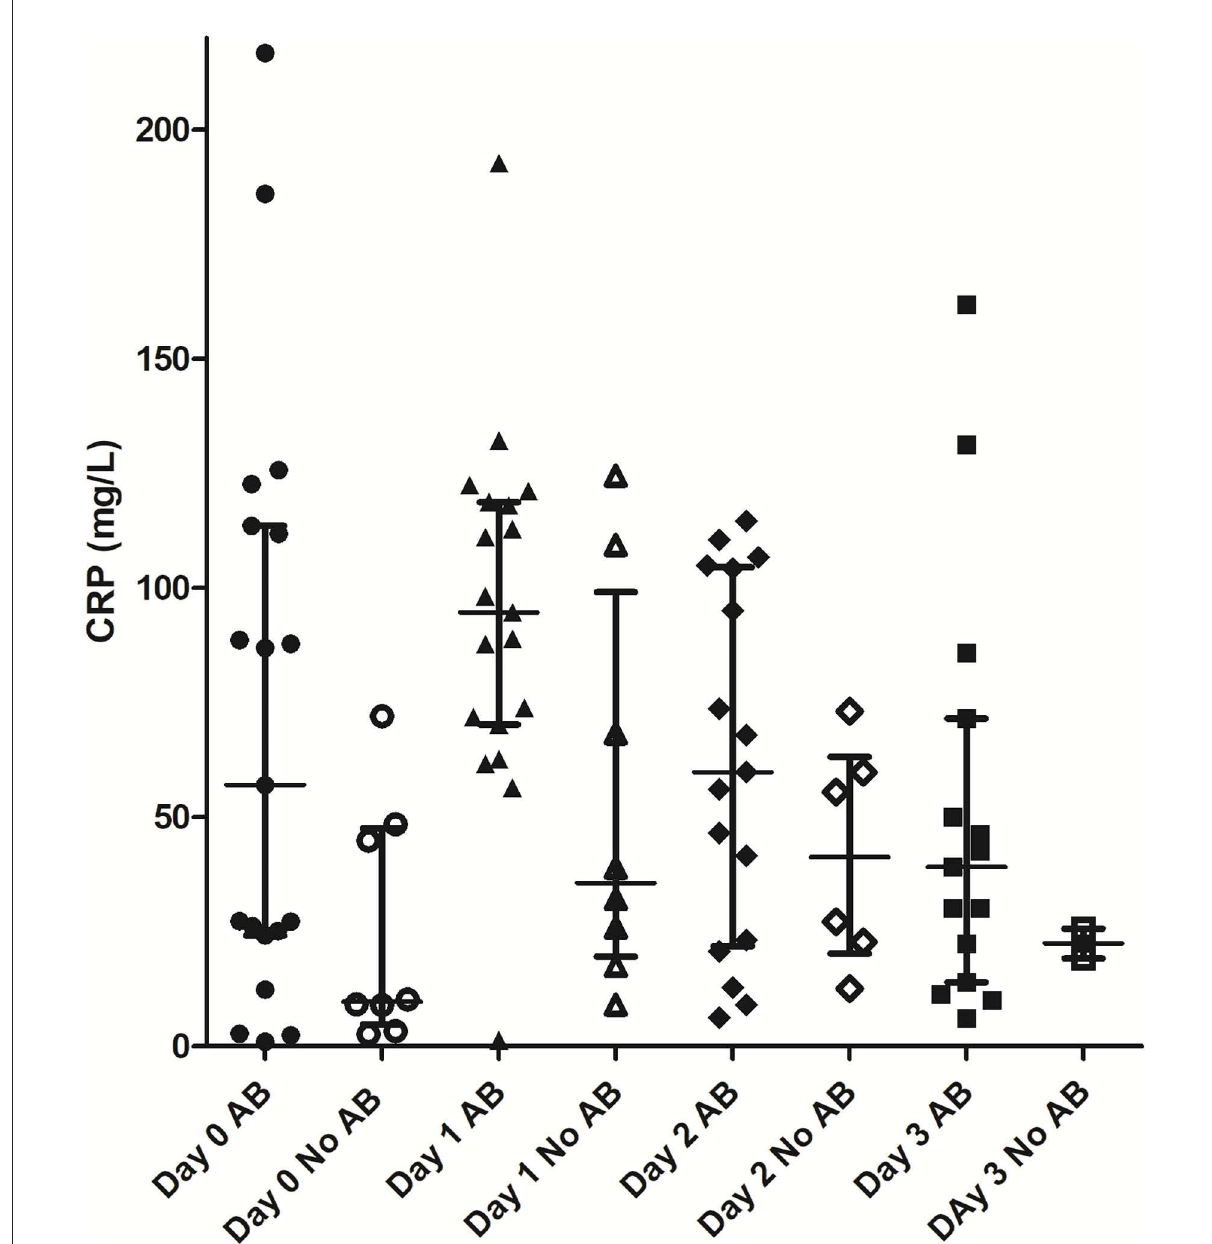
FIGURE1 Comparison of CRP values between patients with and without antimicrobial treatment. AB, antimicrobial treatment; CRP, C-reactive